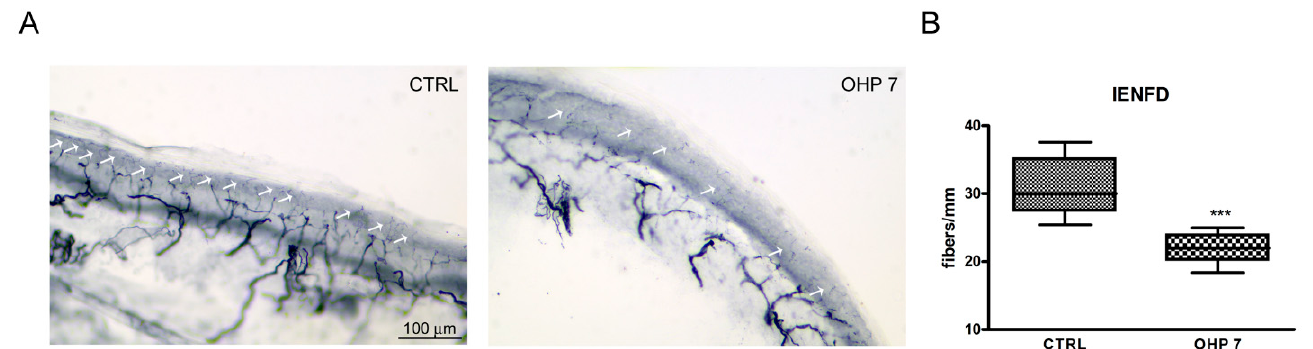
Figure 5. IENFD at the end of treatment. In ( A ), representative images of IEFND in both groups are shown; white arrows point out small fibers visible in each photograph. In ( B ), the graph representing the statistical significance of Mann–Whitney U-test is shown (in the box-and-whiskers graphs median and quartile values, as well as maximum and minimum values, are shown; *** p < 0.001 vs. CTRL). CTRL: control group; OHP7: OHP-treated group.